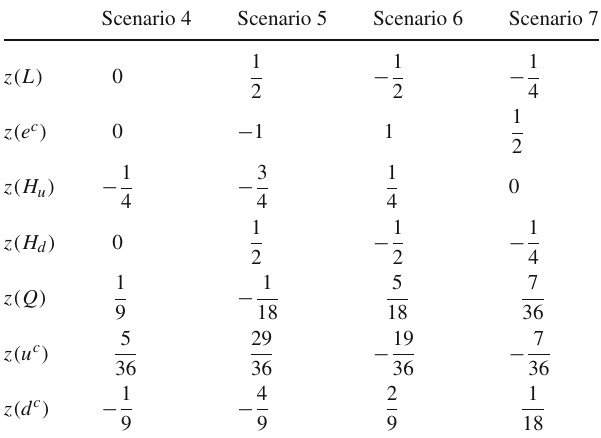
Table 10 Two examples of values of the hypercharges for the exotic quarks K and D using condition (40). As discussed in Eq. (5), y ( K c , and 1 , 2 , 3 − y ( K ) and y ( D c ) = − y ( D ) . These values are independent of the i i i solutions for z ( F ) , with F denoting the exotic quarks